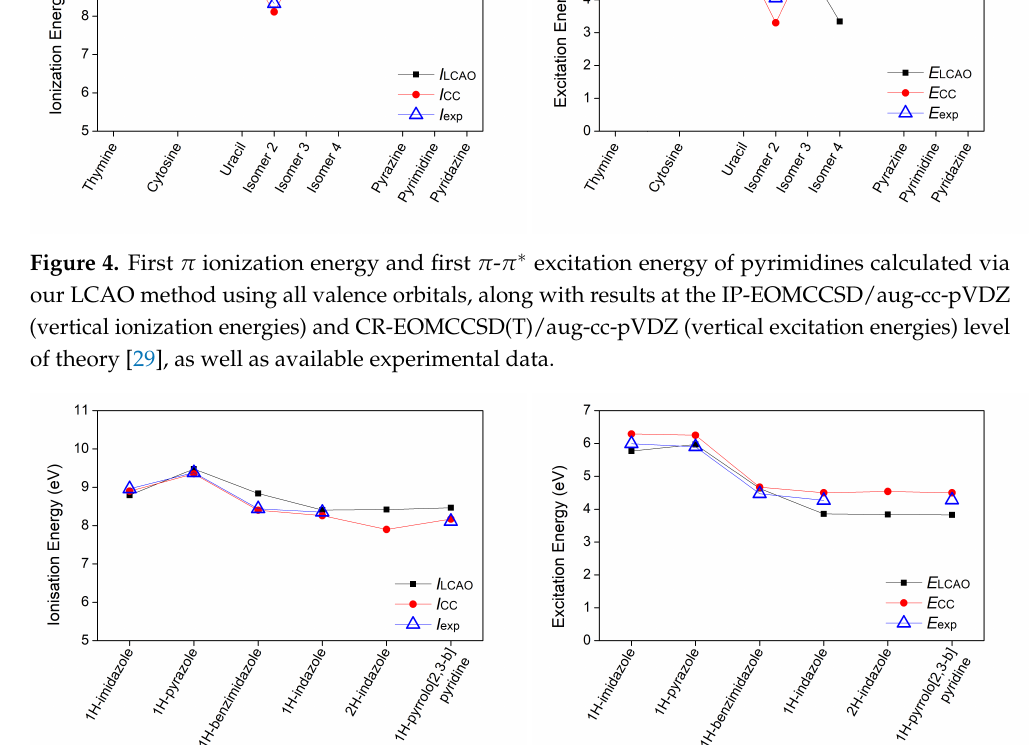
Figure 5. First π ionization energy and first π - π ∗ excitation energy of other planar heterocyclic molecules calculated via our LCAO method using all valence orbitals, along with results calculated at the IP-EOMCCSD/aug-cc-pVDZ (vertical ionization energies) and CR-EOMCCSD(T)/aug-cc-pVDZ (vertical excitation energies) level of theory [29], as well as available experimental